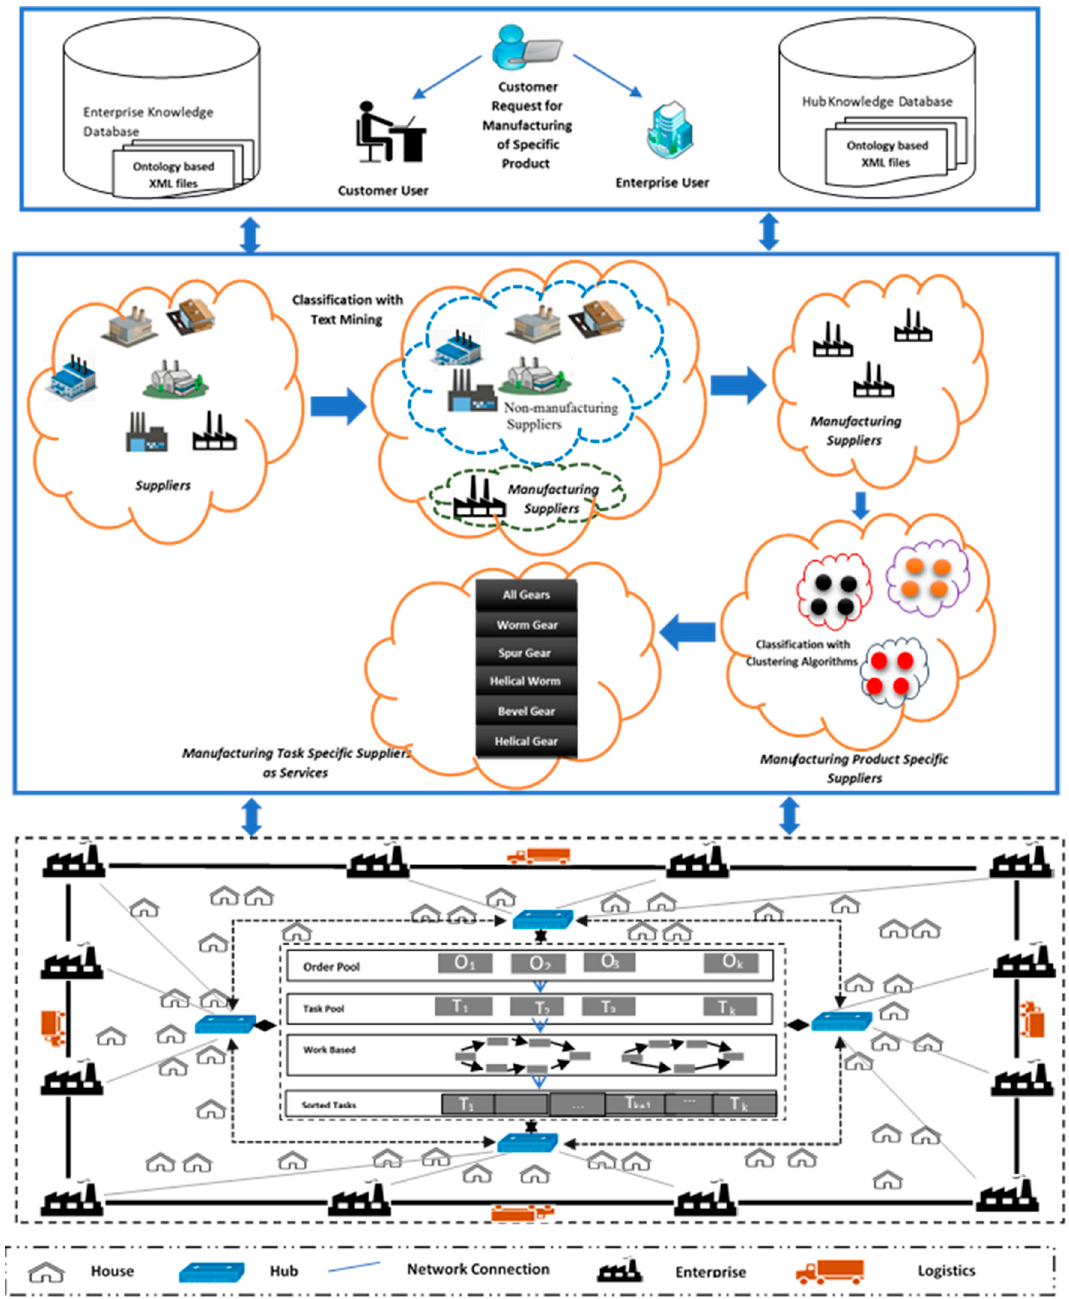
Figure 2. Framework of the proposed network manufacturing approach.